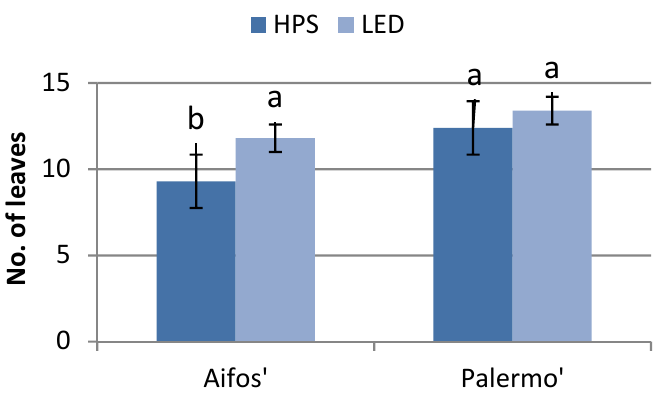
Figure 1. Effects of supplementary lighting with HPS and LED lamps on the numbers of leaves of pepper seedlings, depending on the cultivar. The mean values marked with the same letters do not differ significantly according to the Tukey HSD test at α = 0.05. The bars represent means ± SE (Standard Error).